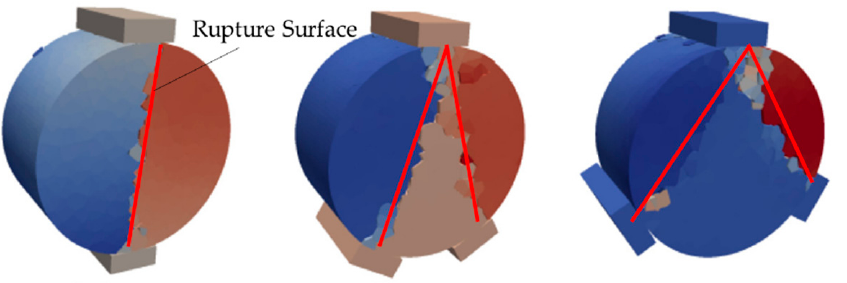
Figure 11. A diagram of crushing morphology of cylindrical particles under different contact tions [40].